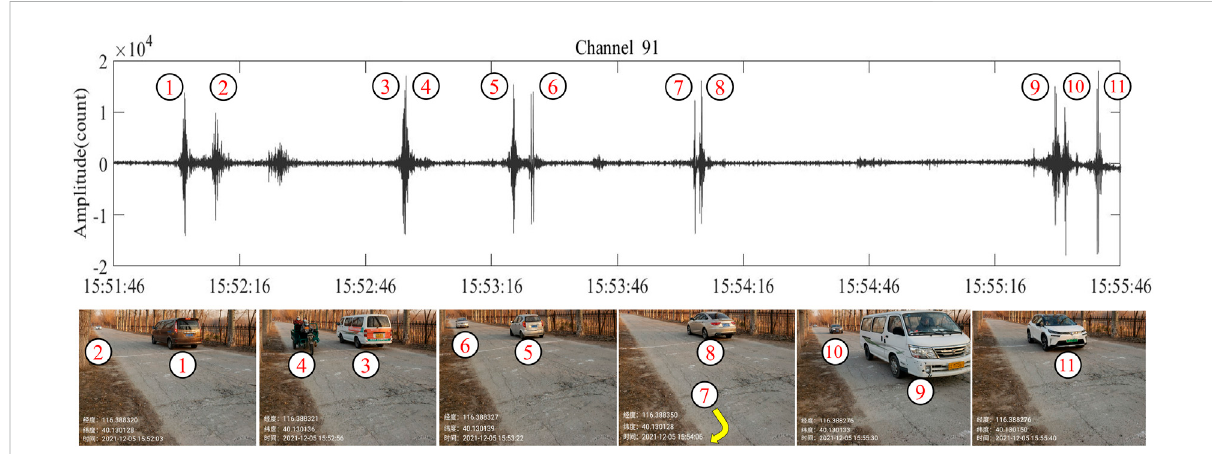
FIGURE 4 Cars across the cross-road fi ber cable and their raw signals in the No. 91 DAS channel in the 4-min period. The cross-road fi ber is beneath the white line in pictures. The events are labeled with numbers by time order. Cars No. 3 and No. 4 passed the channel almost the same time, and their waves are stacked together. Car No. 7 was not photographed since it turned to the restaurant as the yellow arrow indicates and did not have any signals captured on channels 191 – 315 during that time. Cars No. 2 and No. 4 also did not go through channels 191 – 315, according to our manual waveform